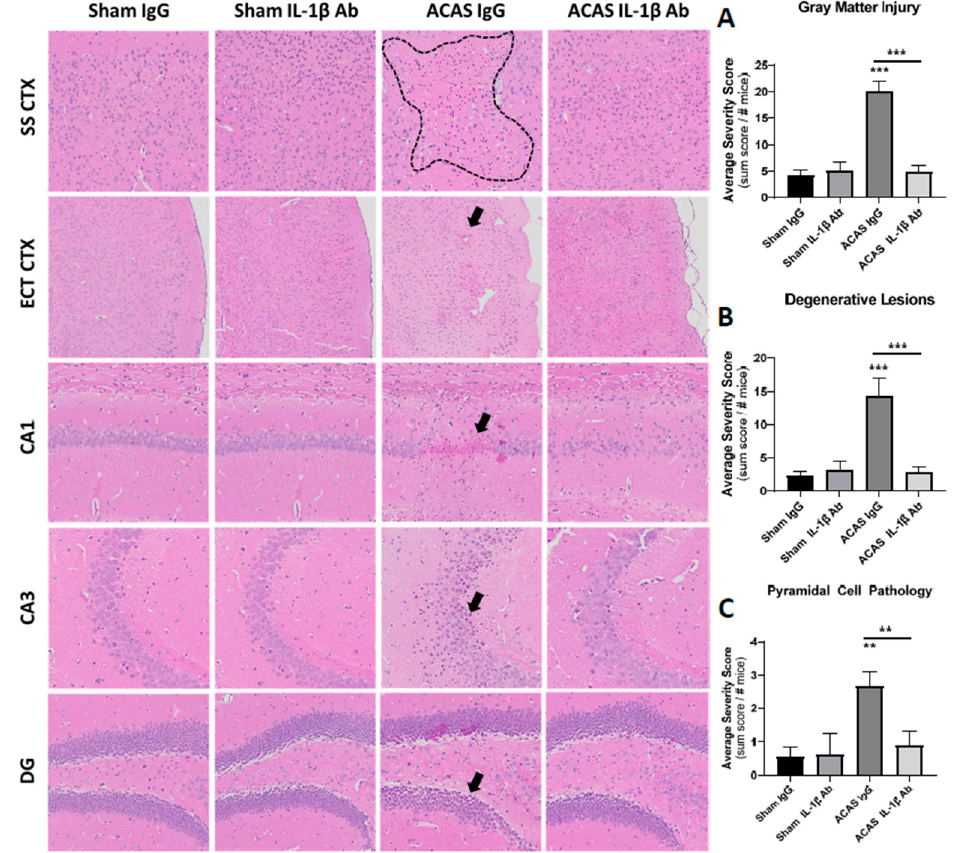
Figure 3. Grey matter pathology at 42 days after ACAS or sham surgery and the initiation of IL-1 β antibody or IgG treatment. Depicted are the four treatment groups: sham + IgG, sham + IL-1 β Ab, ACAS = IgG, and ACAS + IL-1 β Ab for the following brain regions: SSCTX = somatosensory cortex; ECTCTX = entorhinocortex; CA1 and CA3 = regions of the hippocampus, and DG = dentate gyrus of the hippocampus. Areas shown with dotted lines or arrows are examples of lesions that were quantified as shown in Table 1. Dashed lines in the SSCTX outline a degenerative lesion; the arrow in the ECT CTX indicates a condensed lesion; the arrows in the CA1, CA2, and DG show cell loss, Bar graphs shown in ( A – C ) are mean ± SEM for lesion severity scores for each of the four treatment groups. N = 9 mice/group. ** p < 0.01 vs. the sham + IgG group or the ACAS + IgG group. *** p < 0.001 vs. sham + IgG group or the ACAS + IL1- β Ab group.